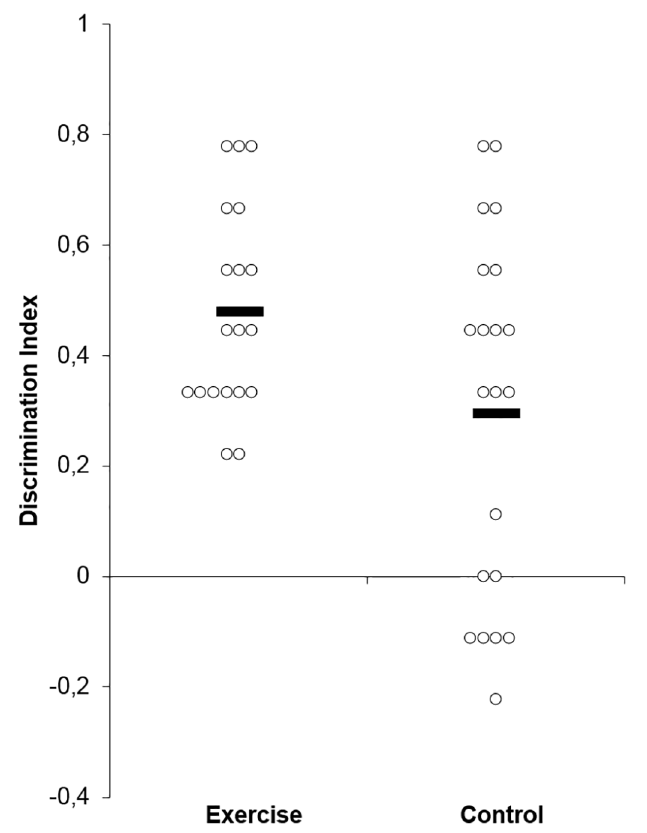
Figure 3. Mean and individual discrimination index scores across the exercise and control groups (Experiment